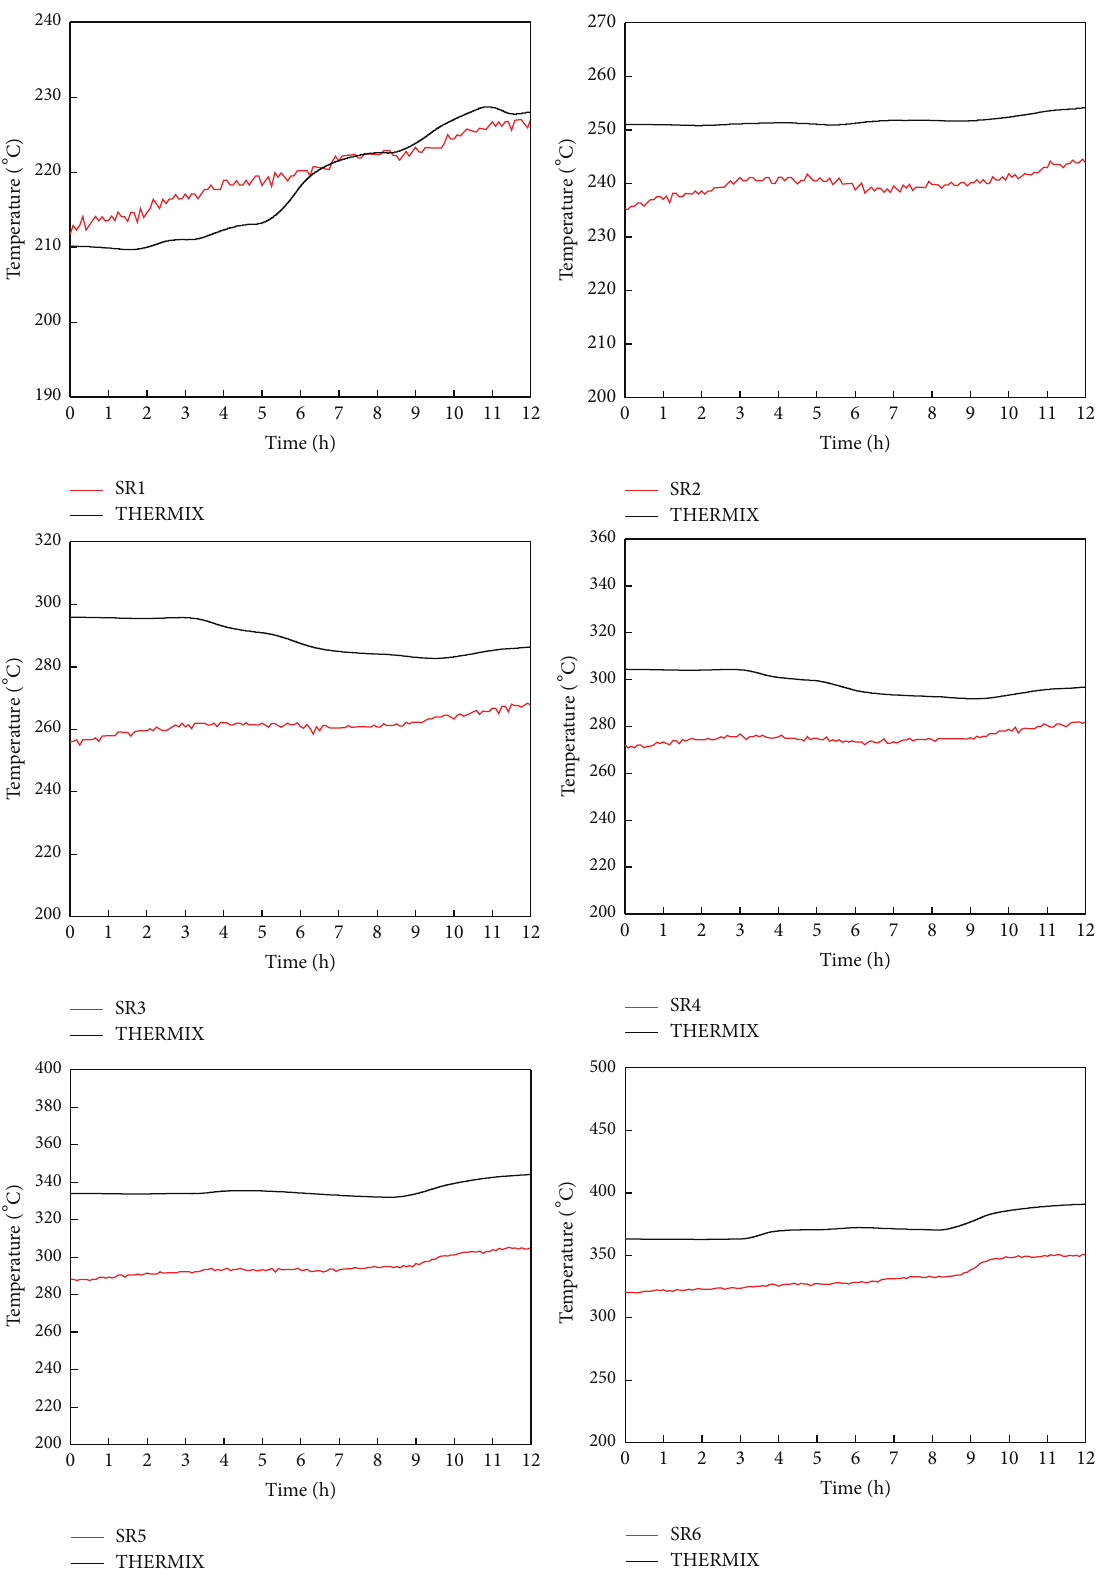
Figure 12: Temperature transient of the side internals (upper